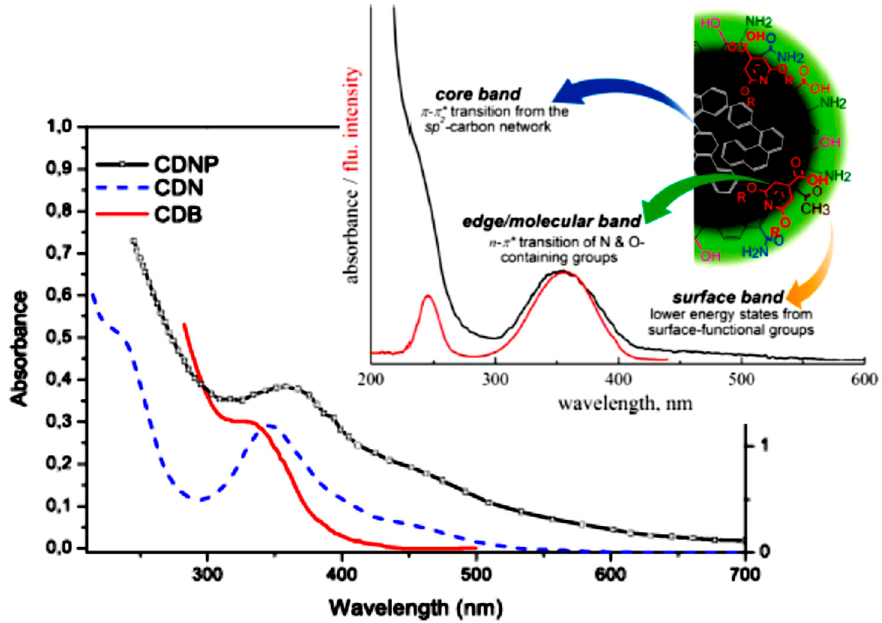
Figure 2. Absorption spectra of bare (CDB) and nitrogen doped (CDN and CDNP) CDs (Reprinted from [29] with permission of American Chemical Society, copyright 2018); Inset: Absorption and excitation spectra with assignation scheme (Reprinted from [48] with permission of American Chemical Society, copyright 2017)